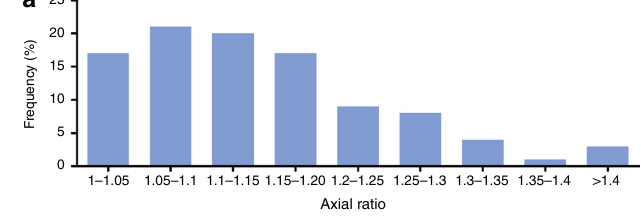
proteins were detected in the cell (Supplementary Fig.